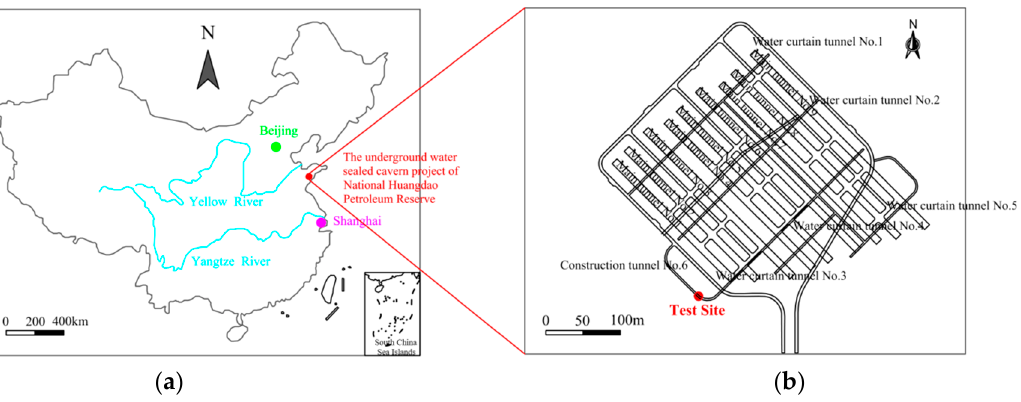
Figure 3. Slug test site schematic diagram of National Huangdao Petroleum Reserve project. ( a ) geographical position. ( b ) the distribution shape of underground